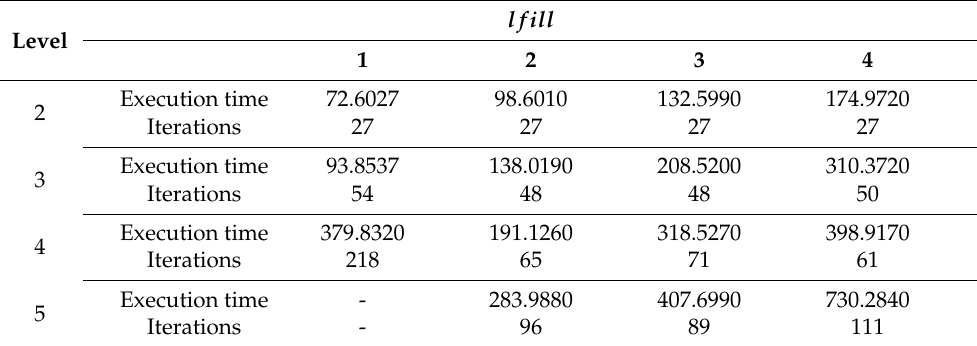
Table 7. Convergence behavior and performance of V cycle of AGAMG in combination with deflation technique and MGenFAspI with droptol = 0 and different values of l fill for 2D Poisson model problem with nx =